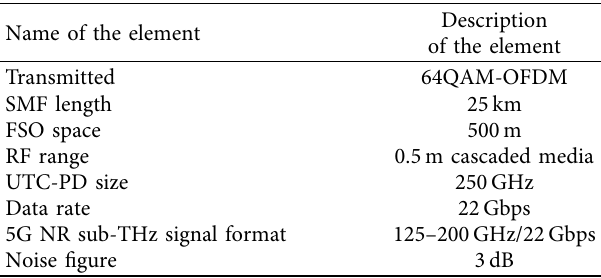
Figure 2: 5G NR based united fber and FSO framework. Table 1: Parameters range with units applied for analyzing 5G NR based fber-FSO system